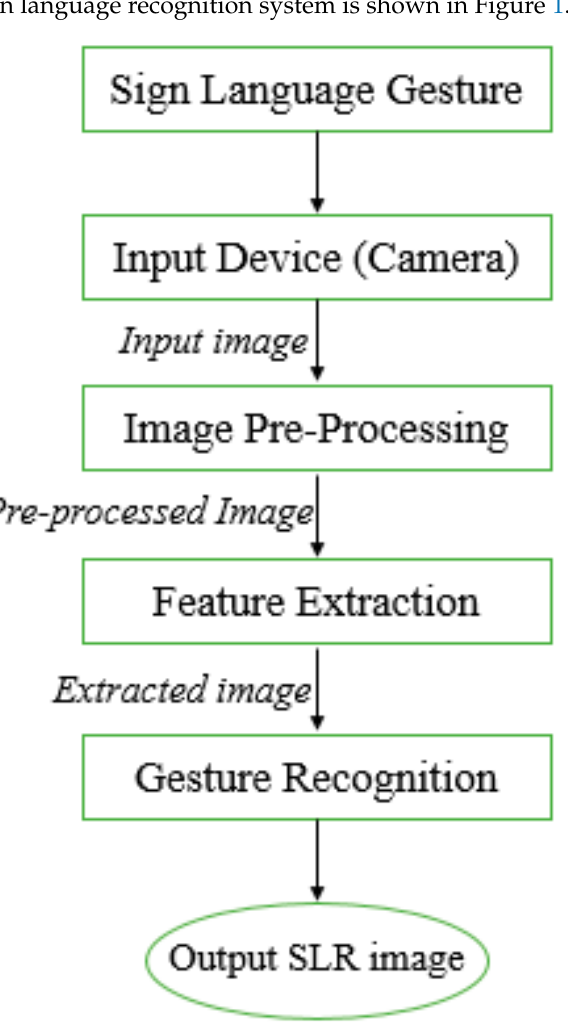
Figure 1. Processing steps for the vision sensor-based SLR system.